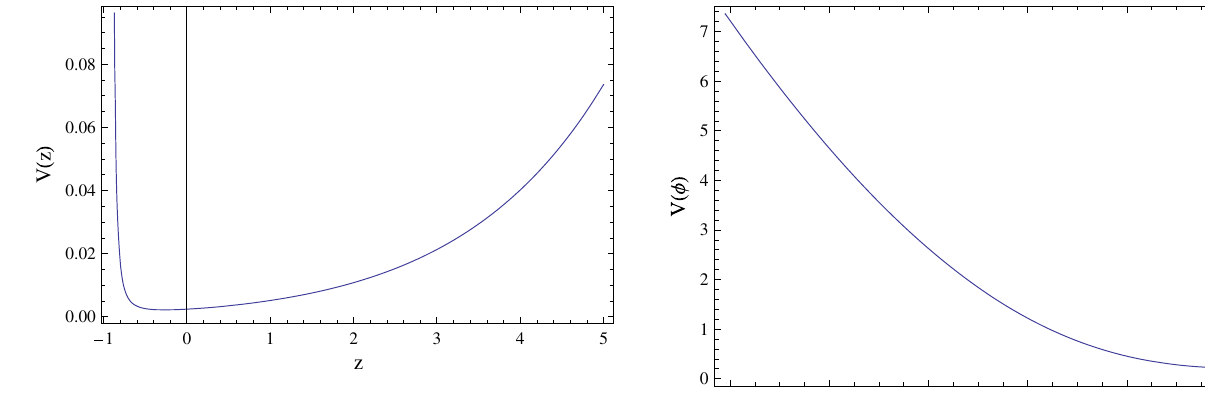
Fig. 22 Variation of V ( z ) with the variation of z (Model III) by con- sidering the best fit values w 0 = − 0 . 754 ,w 1 = 0 . 261